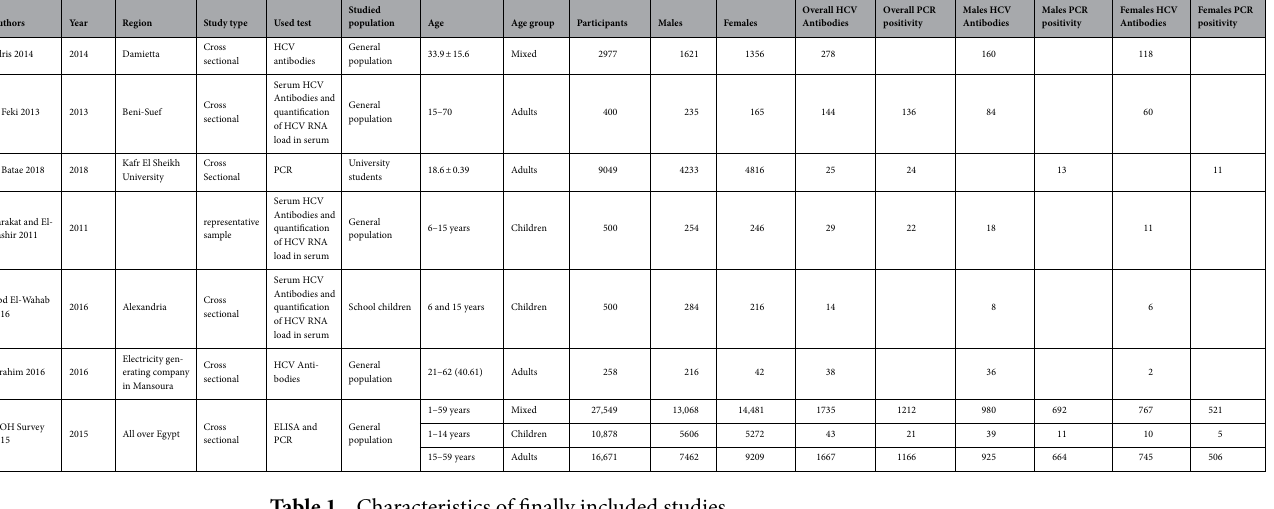
Table 1. Characteristics of finally included